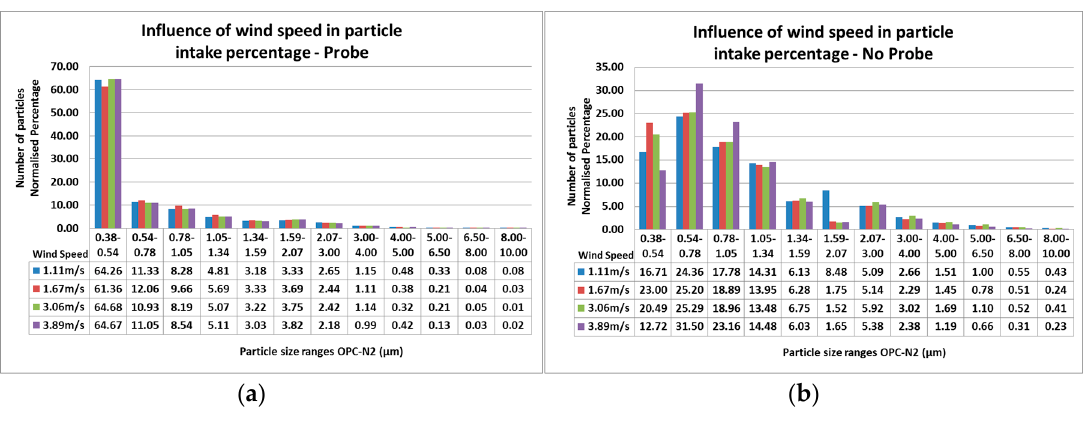
Figure 11. Influence of wind speed variation over particle counting readings per particle size range for ( a ) OPC-N2 with a sampling probe attached, and ( b ) OPC-N2 without a sampling probe. For the TSI DRX, the concentration for different particle size fractions was analysed. Particle